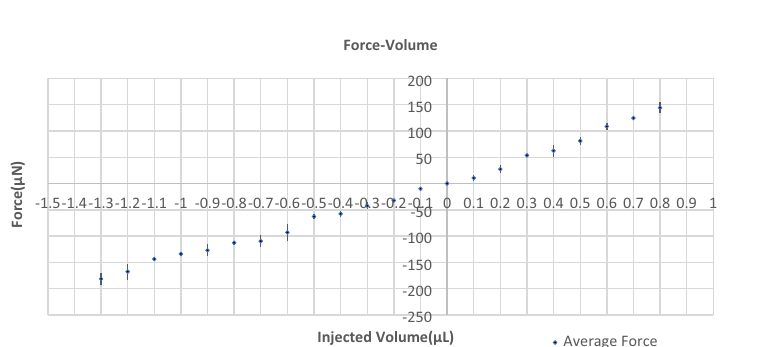
Figure 8. Force measurement by using an AE-800 sensor. ( a ) An optical image of the microgripper and the force sensor. The suggested placement of the microgripper and the sensor can be seen. ( b ) The side view of a finger and the cantilever of the sensor.